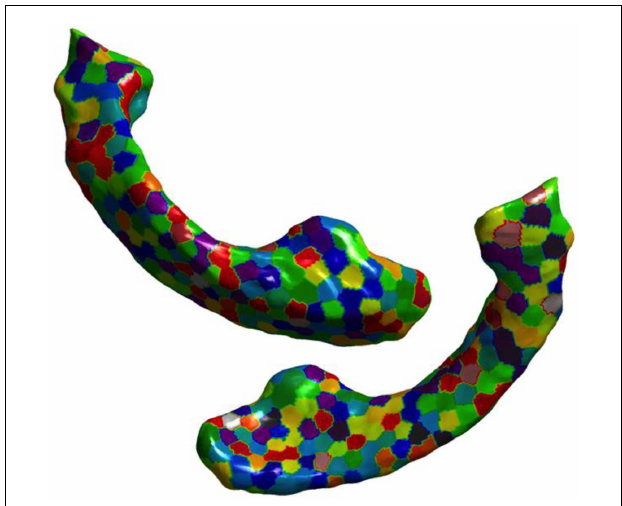
FIGURE 3 |Visualization of partitions is shown on the ventricular surface of the atlas .The surface is partitioned into 300 partitions via k -means clustering of vertices. In lateral ventricles as well, we can see that the partitions are small enough to capture the variation in the deformation in the curved